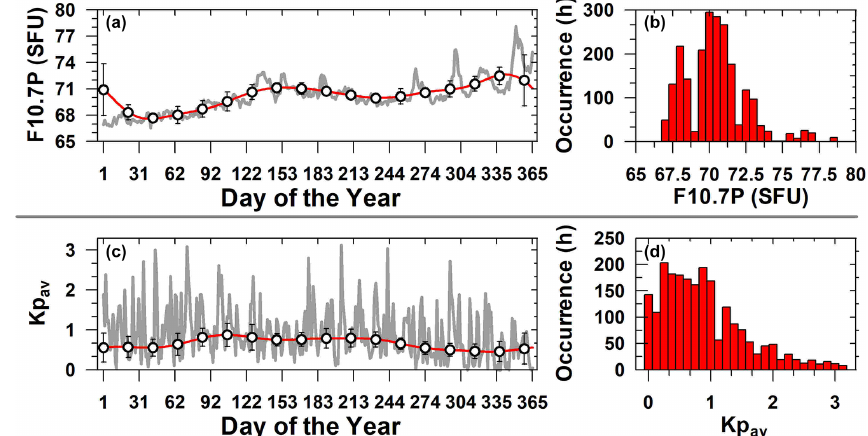
Figure 2. Variability of the solar and geomagnetic activity quantified by the F10.7P (a, b) and the Kp av indices (c, d) . (a) and (c) show the geophysical conditions as a function of the day of the year, while (b) and (d) show their corresponding number of occurrences (in hours) under different geophysical conditions. The dots of (a) represent the 41d’ averages and the standard deviation of F10.7P, while the dots of (c) represent the same range of days of (a) and (b) and its respective standard deviation but for Kp av ≤ 2 . 3 (geomagnetic condition used to construct the quiet time condition of h’IL and ftIL) (Note: (a) and (c) show the geophysical conditions as a function of the day of the year (gray line)). The red continuous lines are the reconstruction of these variabilities using fast Fourier transform (FFT). The given occurrence in the right column of panels is the number of hours for a given interval of Kp av (0.125) and F10.7P